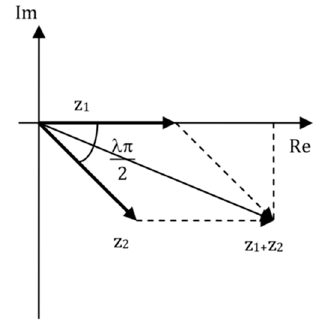
Figure 19. Vector form of a FO-PI controller.